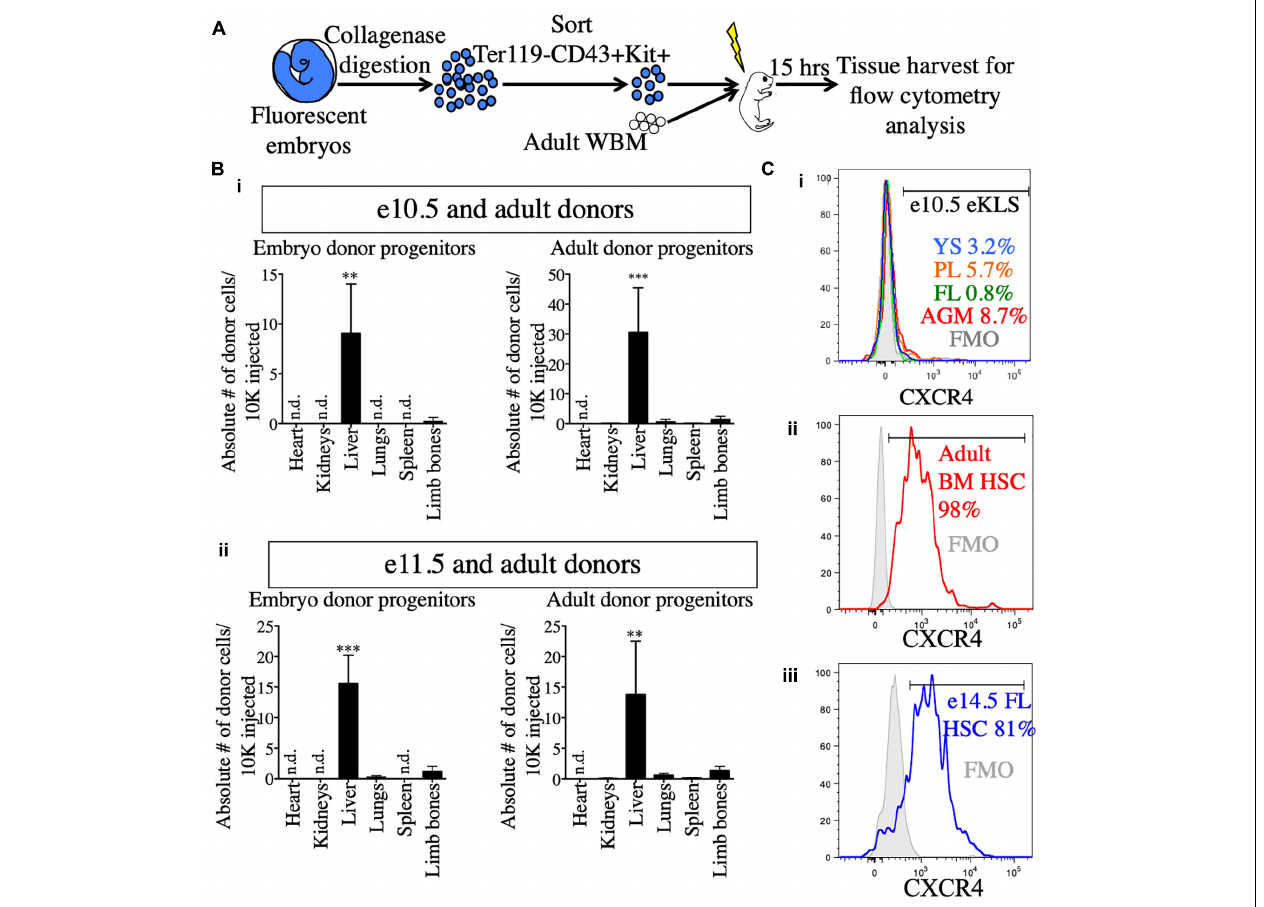
FIGURE 5 | Neonatal liver harbors transplanted embryonic and adult donors in the short-term post-transplant. (A) Schematic representation of short-term homing assay. Ter119- CD43+ Kit+ progenitors were sorted from whole embryos, mixed with 100,000 adult WBM and transplanted into irradiated P1-P4 neonatal recipients. 15 h post-transplant, organs were harvested for FACS analysis. (B) Detection of donor progenitors shortly after transplant. Absolute number of Ter119- CD43+ Kit+ progenitors originating from e10.5 (i) and e11.5 (ii) embryos and the accompanying adult source normalized to 10,000 injected cells are shown in the heart, kidneys, liver, spleen, and limb bones of the neonatal recipients. Tissues were harvested and processed in their entirety. “Limb bones” includes femurs and tibias from the hind limbs and humeri from the forelimbs. ∗∗ p ≤ 0.01 and ∗∗∗ p ≤ 0.001 (Student’s unpaired t test). e10.5, n = 3 (two independent experiments); e11.5, n = 4. (C) Surface expression of CXCR4 in e10.5 pre-HSCs (i) , adult BM HSCs (ii), and e14.5 FL HSCs (iii) . Percentages of CXCR4+ cells are shown in histograms. FMOs were used to set the positive gate. Adult BM and e14.5 FL HSCs were stained and analyzed in the same experiment. e10.5 pre-HSCs were analyzed in a separate experiment alongside appropriate positive staining controls (adult BM HSCs, data not shown). FMO, fluorescence minus one; n.d., not